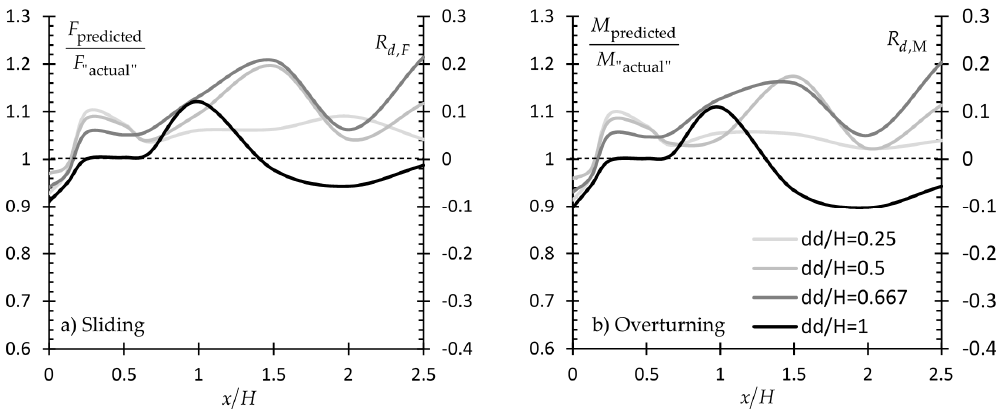
Figure 20. Example #1: F predicted / F ”actual” ( a ) and M predicted / M ”actual” ( b ) vs. x / H curves for various d d / H values and for both the sliding and overturning failure cases (see also Table 1 and Figure 1).